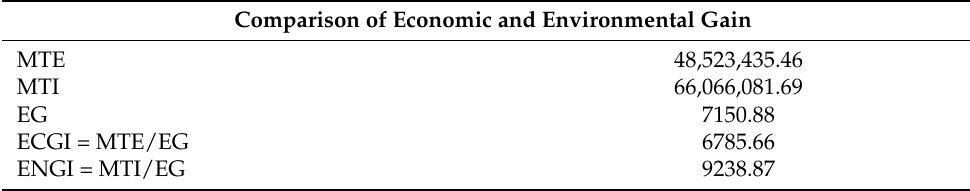
Table 8. Indexes of economic and environmental